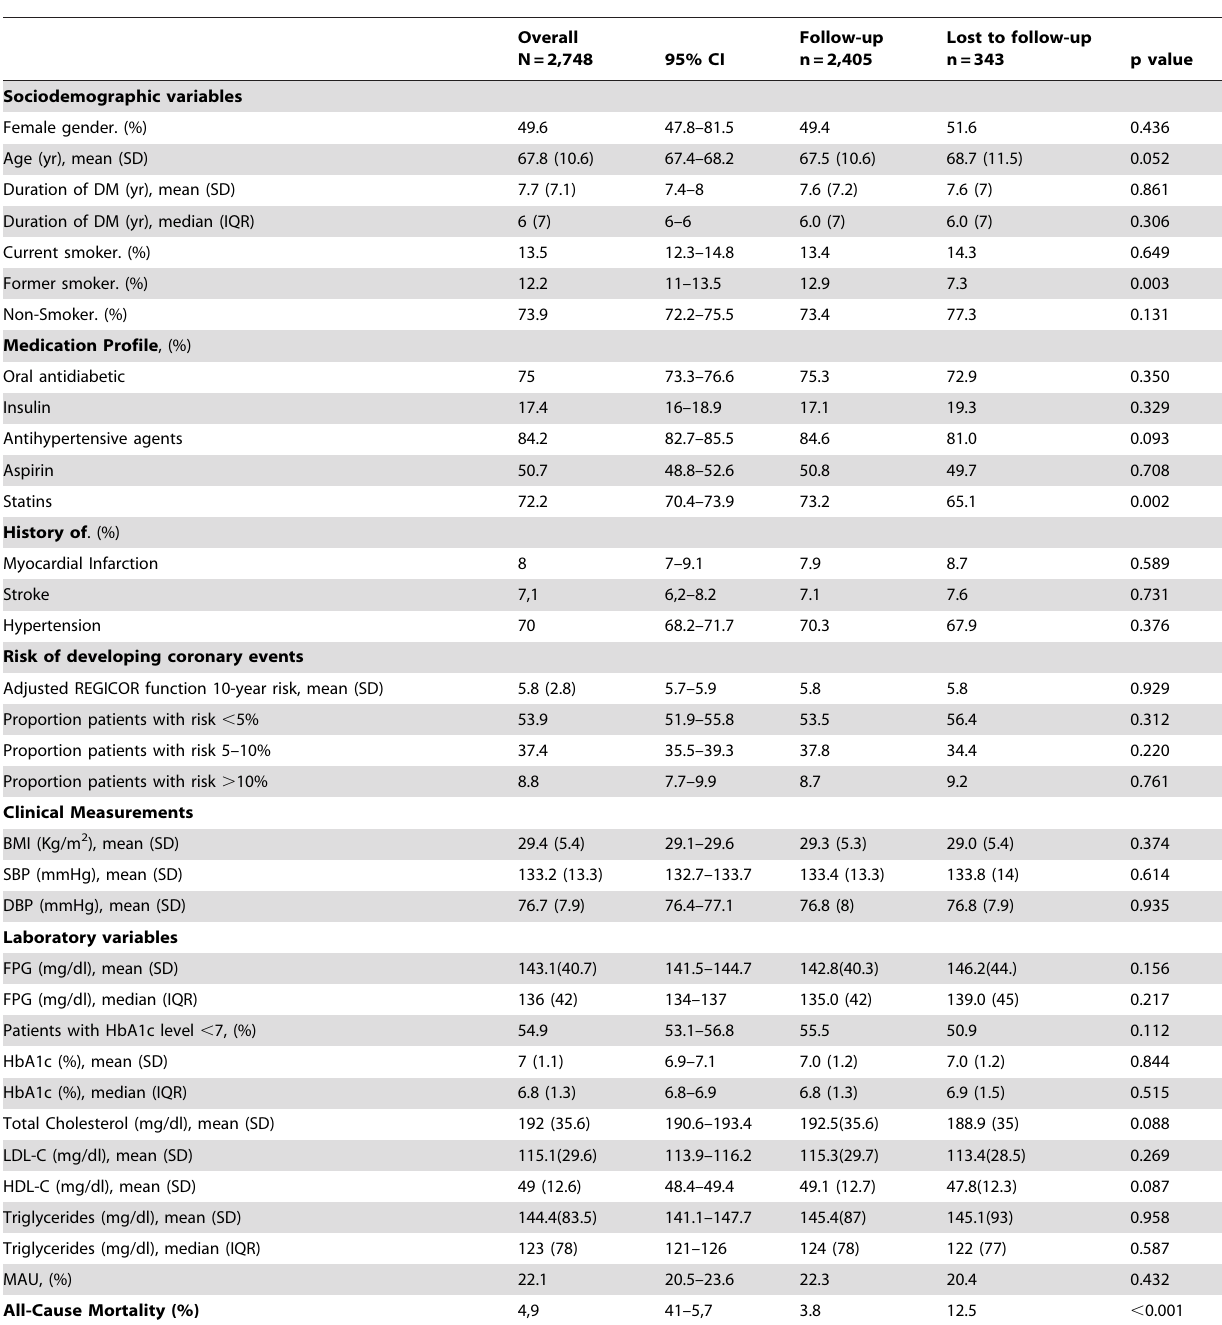
Table 1. Baseline characteristics of MADIABETES Diabetic Retinopathy Cohort (N =2,748), and mortality rate during follow-up.